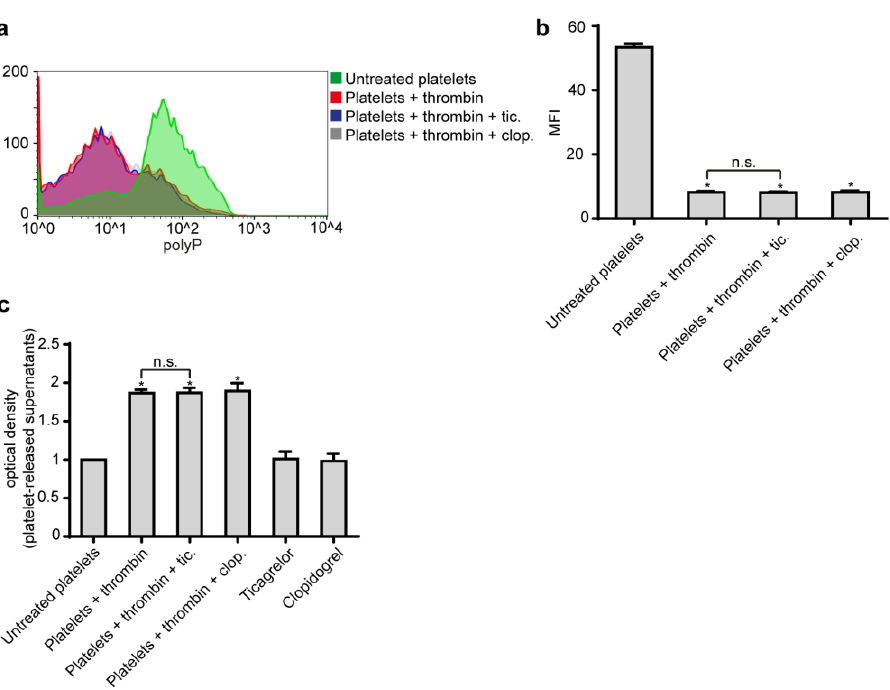
Figure 3. Ticagrelor does not inhibit polyP release from platelets. ( a ). Representative flow cytometry analysis and ( b ) . relative mean fluorescent intensity (MFI) of polyP on control platelets treated with thrombin, with or without pre-treatment with Ticagrelor or Clopidogrel. MFI – mean fluorescence intensity. ( c ) . Quantification of the released polyP with JC-D8 polyP-specific fluorescent probe. Relative I integrated optical density OD was calculated compared to control platelets value. ( a ). One representative out of six independent experiments is shown. ( b , c ) Data from six independent experiments presented as mean ± SD. Statistical significance * p < 0.05. n.s.: non-significant.